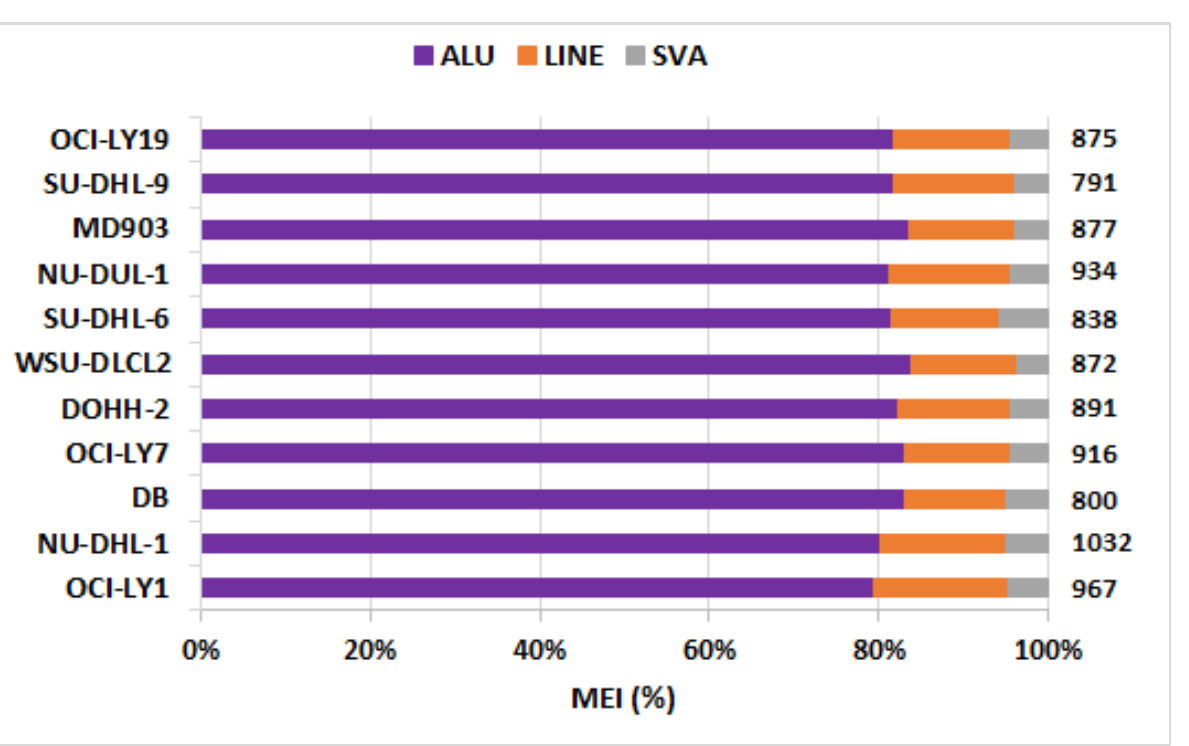
Figure 1. Distribution of five structural variations across DLBCL cell lines, shown as a component bar graph, while the number of SSVs is depicted by ‘ × ’.